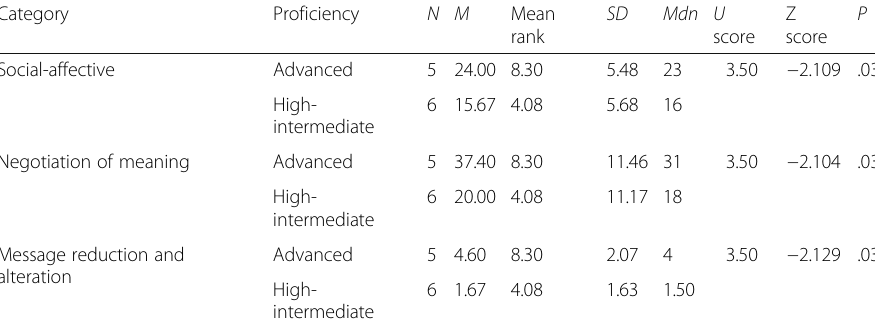
Table 3 Communication Strategy Use by Category Showing Significant Differences between Advanced and High-intermediate Participants